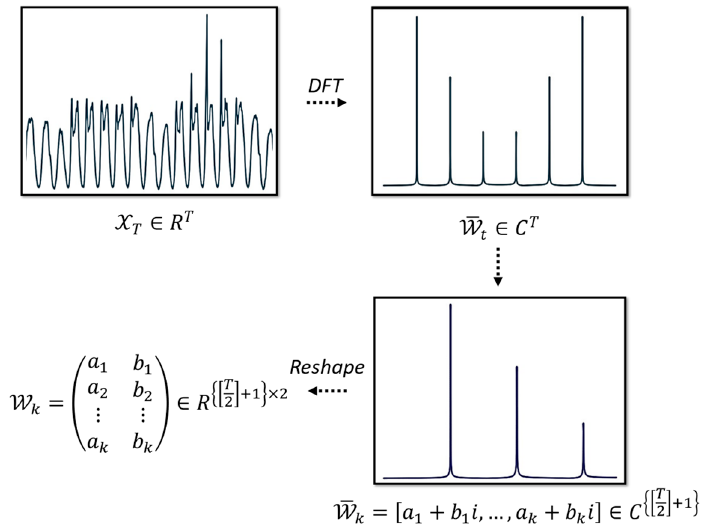
Figure 1. Preprocessing method, where 𝑖 is imaginary unit.